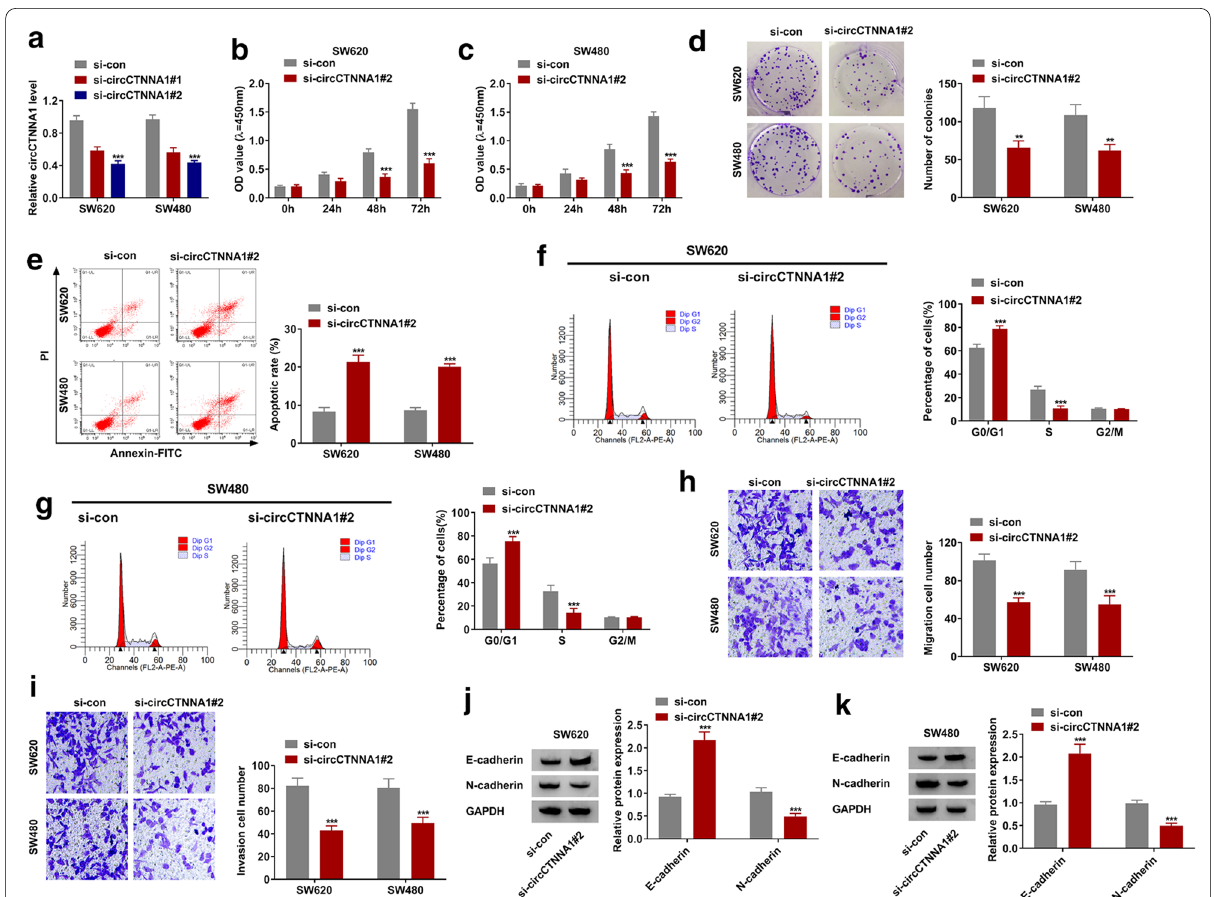
Fig. 2 Silencing of circCTNNA1 suppressed CRC cell progression. a The transfection efficiencies of si-circCTNNA1#1 and si-circCTNNA1#2 were confirmed by detecting circCTNNA1 expression using qRT-PCR in SW620 and SW480 cells. b – k SW620 and SW480 cells were transfected with si-con or si-circCTNNA1#2. The viability, number of colonies, apoptotic rate, cell cycle, migration and invasion of cells were determined using CCK8 assay ( b , c ), colony formation assay ( d ), flow cytometry ( e – g ), and transwell assay ( h , i ). j , k The protein expression of E-cadherin and N-cadherin was measured using WB analysis. ** p < 0.01, *** p <